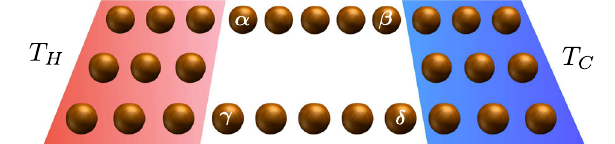
Fig. 1 Sketch of the thermo-electric transport nanodevice studied here. The nine leftmost and rightmost atoms are connected to thermal baths at temperature T H and T C , respectively. Due to this temperature imbalance, heat fl ows from the hot to the cold side equally through the two identical branches. This device will be used to study physical phenomena arising from local quantum observa- tions. We tested similar devices with different geometries and lengths of the two branches. The conclusions drawn with the